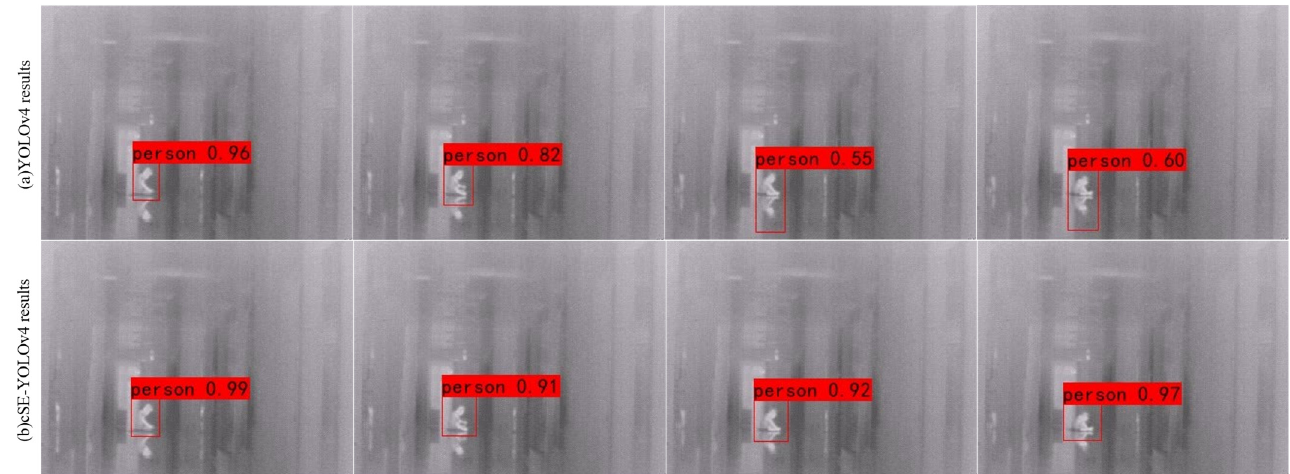
Figure 10. The result of a comparison of four consecutive frames before and after improvement.